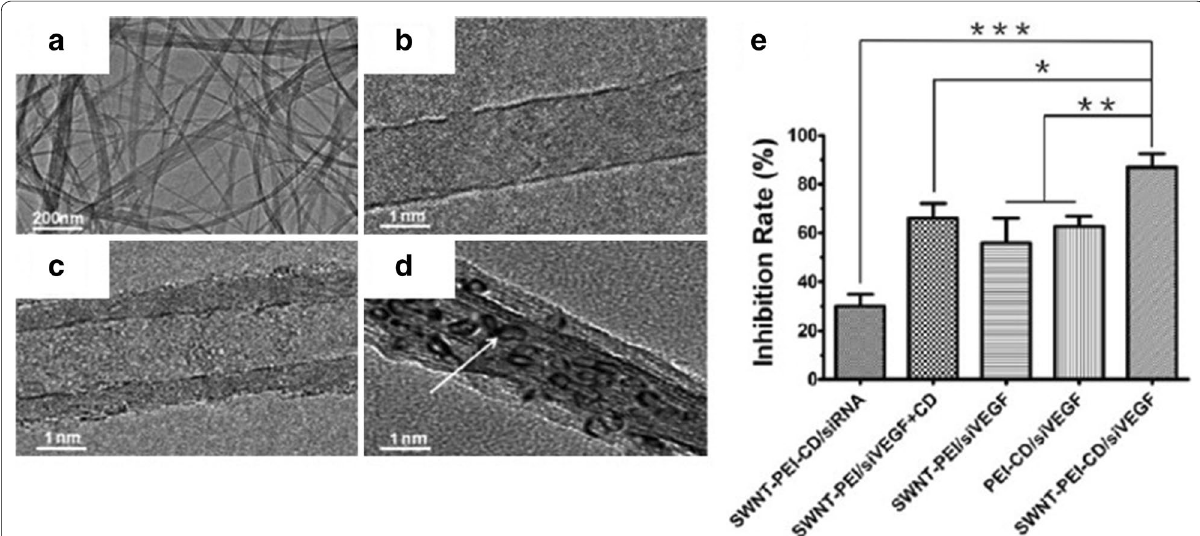
Fig. 8 TEM images of a purified SWNTs, b SWNT (Reproduced with permission